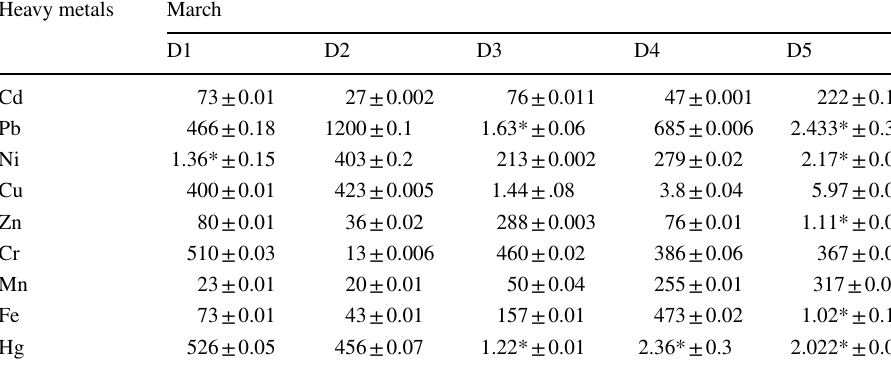
concentration in different drains of HIE during March